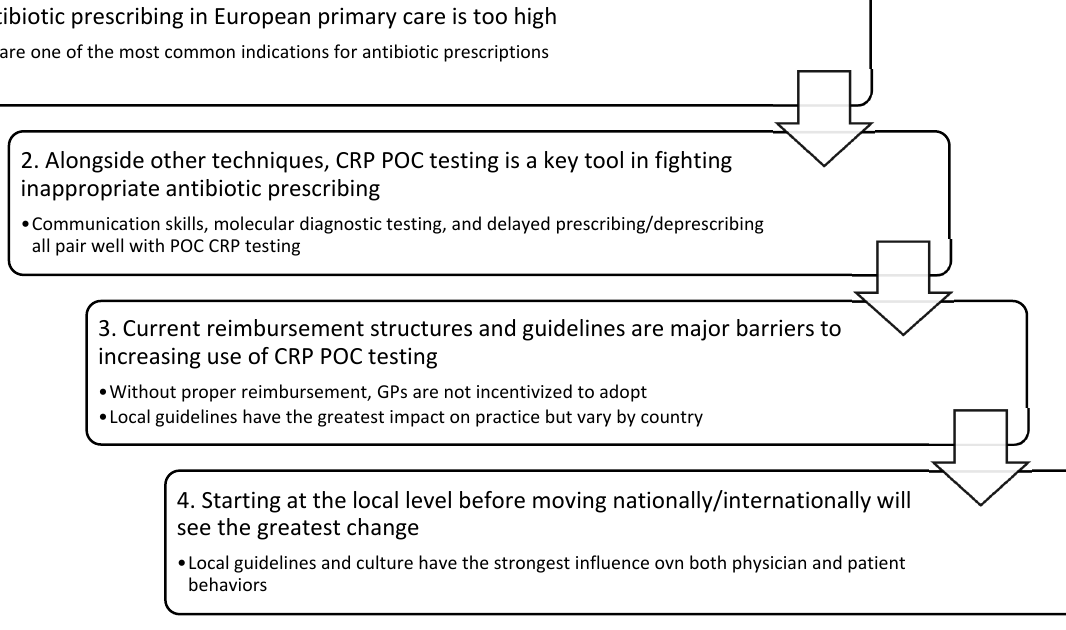
Figure 1. Summary of key findings from the Expert Panel regarding the utility of CRP POC testing in LRTIs.